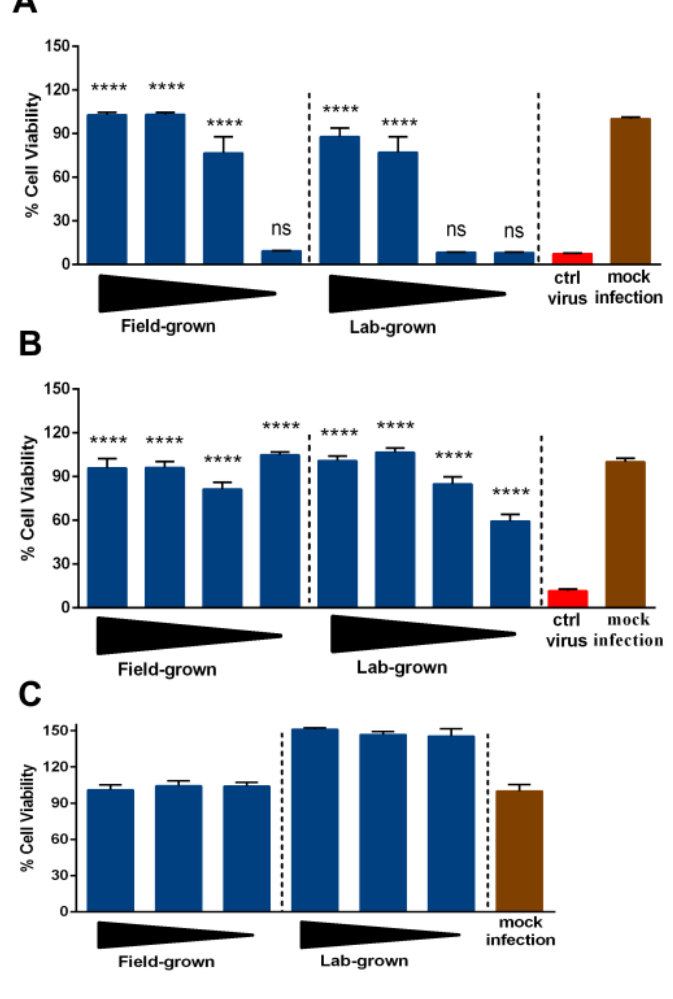
Figure 3. The antiviral efficacy of round-leaved sundew against ( A ) CVA9 and ( B ) CVB3 and its ( C ) cytotoxicity at decreasing concentrations (10%, 5%, and 1% v/v ) tested on human A549 cells. For the antiviral assessment, CVA9 (2 × 10 6 PFU/mL) and CVB3 (2 × 10 5 PFU/mL) were treated with decreasing concentrations (10%, 5%, 1%, and 0.1%, v/v ) of the round-leaved sundew. Average value + standard errors of mean (SEM) are shown. One-way ANOVA followed by Bonferroni test were used to assess the statistical significance of differences between the virus control and test samples (**** = p < 0.0001; ns = non-significant).